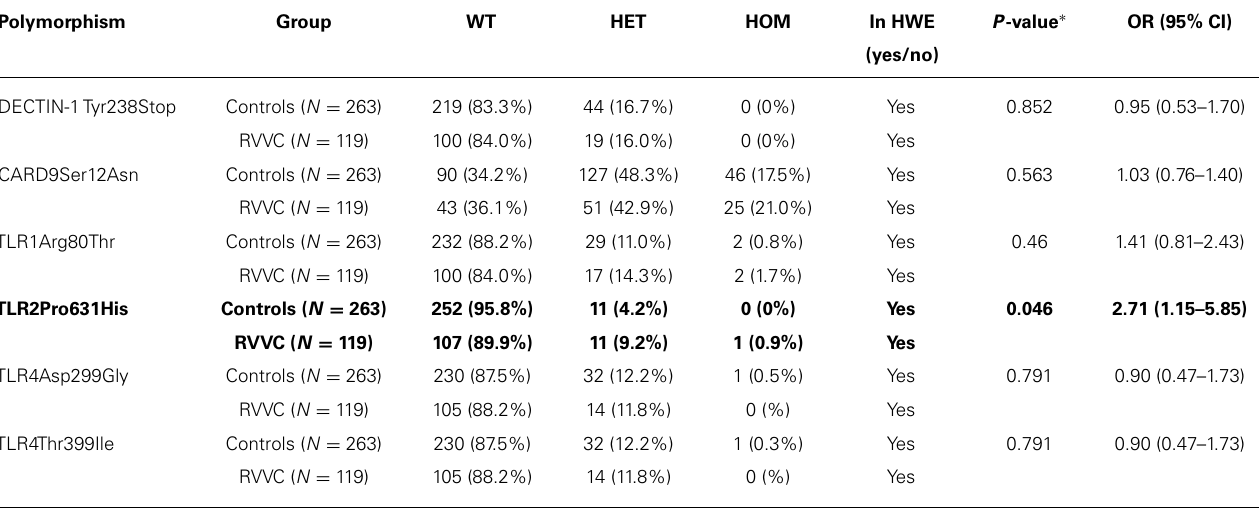
Table 1 | Genetic association of recurrent vulvovaginal candidiasis (RVVC) with polymorphisms in DECTIN-1, CARD9,TLR1,TLR2, andTLR4 genes.